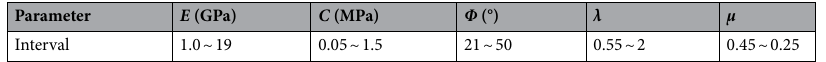
Table 7. Searching intervals of the geomechanical parameters to be identified.